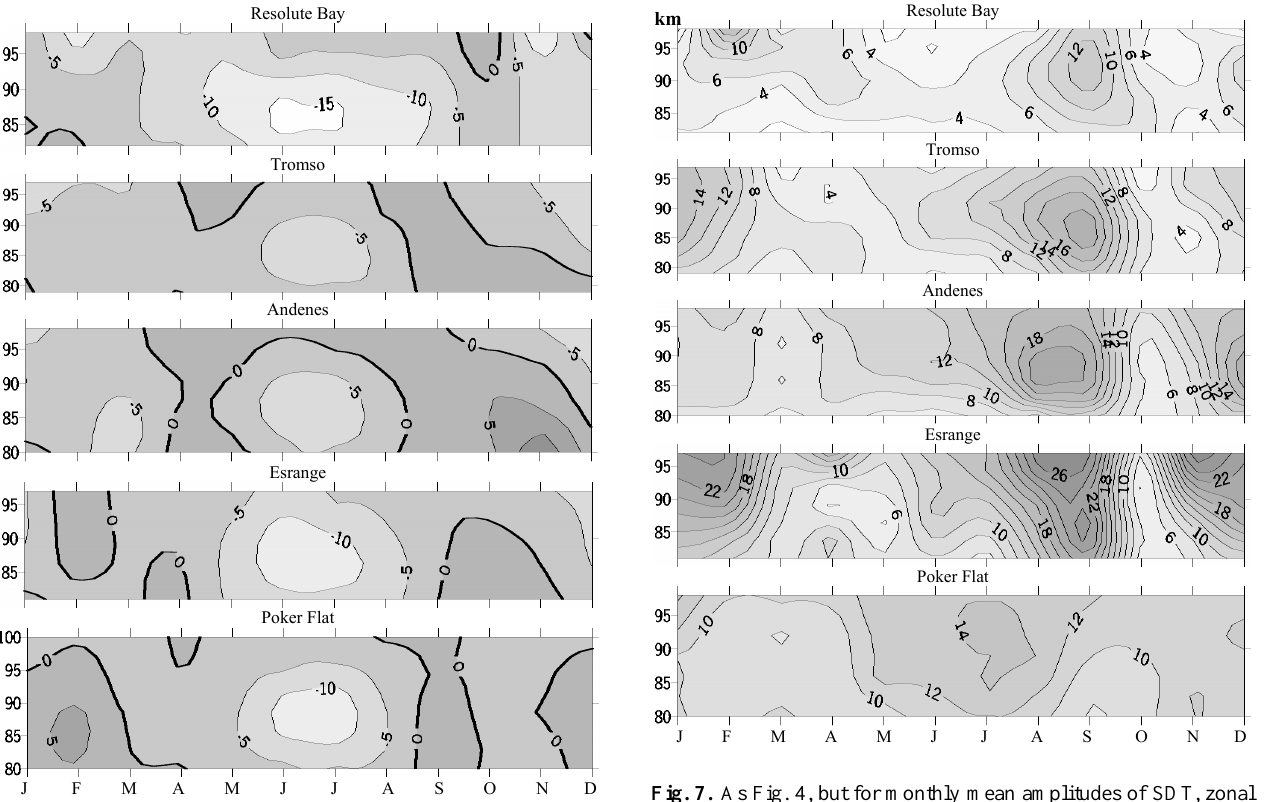
Fig. 7. As Fig. 4, but for monthly mean amplitudes of SDT, zonal